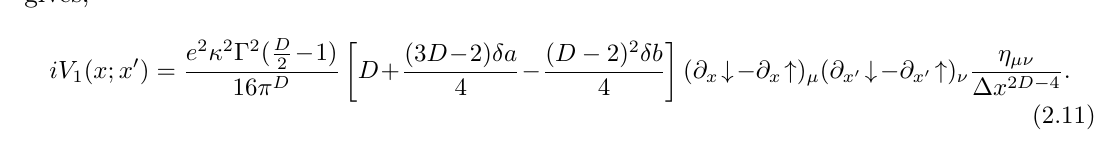
Figure 3 . These diagrams show the contributions from correlations between the force carrier and one of the vertices. Dashed lines represent massive scalars, wavy lines represent photons and curly lines represent gravitons. These graphs have the same topology as Bjerrum-Bohr’s Diagram 7 [16].